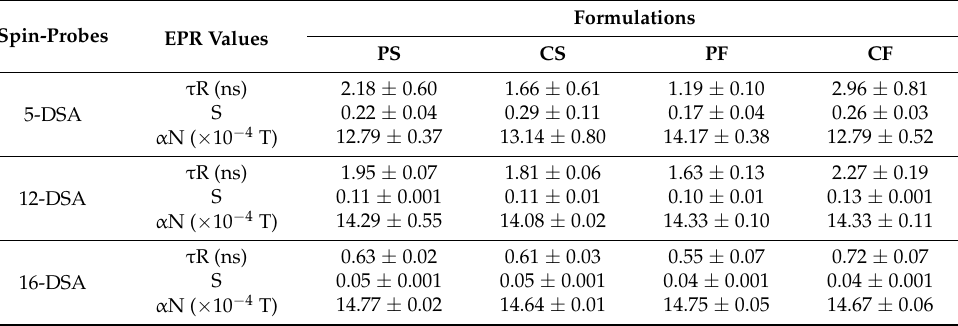
Table 2. Rotational correlation time ( τ R), order parameter (S), and isotropic hyperfine coupling constant ( α N) of 5-DSA, 12-DSA, and 16-DSA in empty and loaded nanoemulsions with soybean (PS, CS) and fish oil (PF,